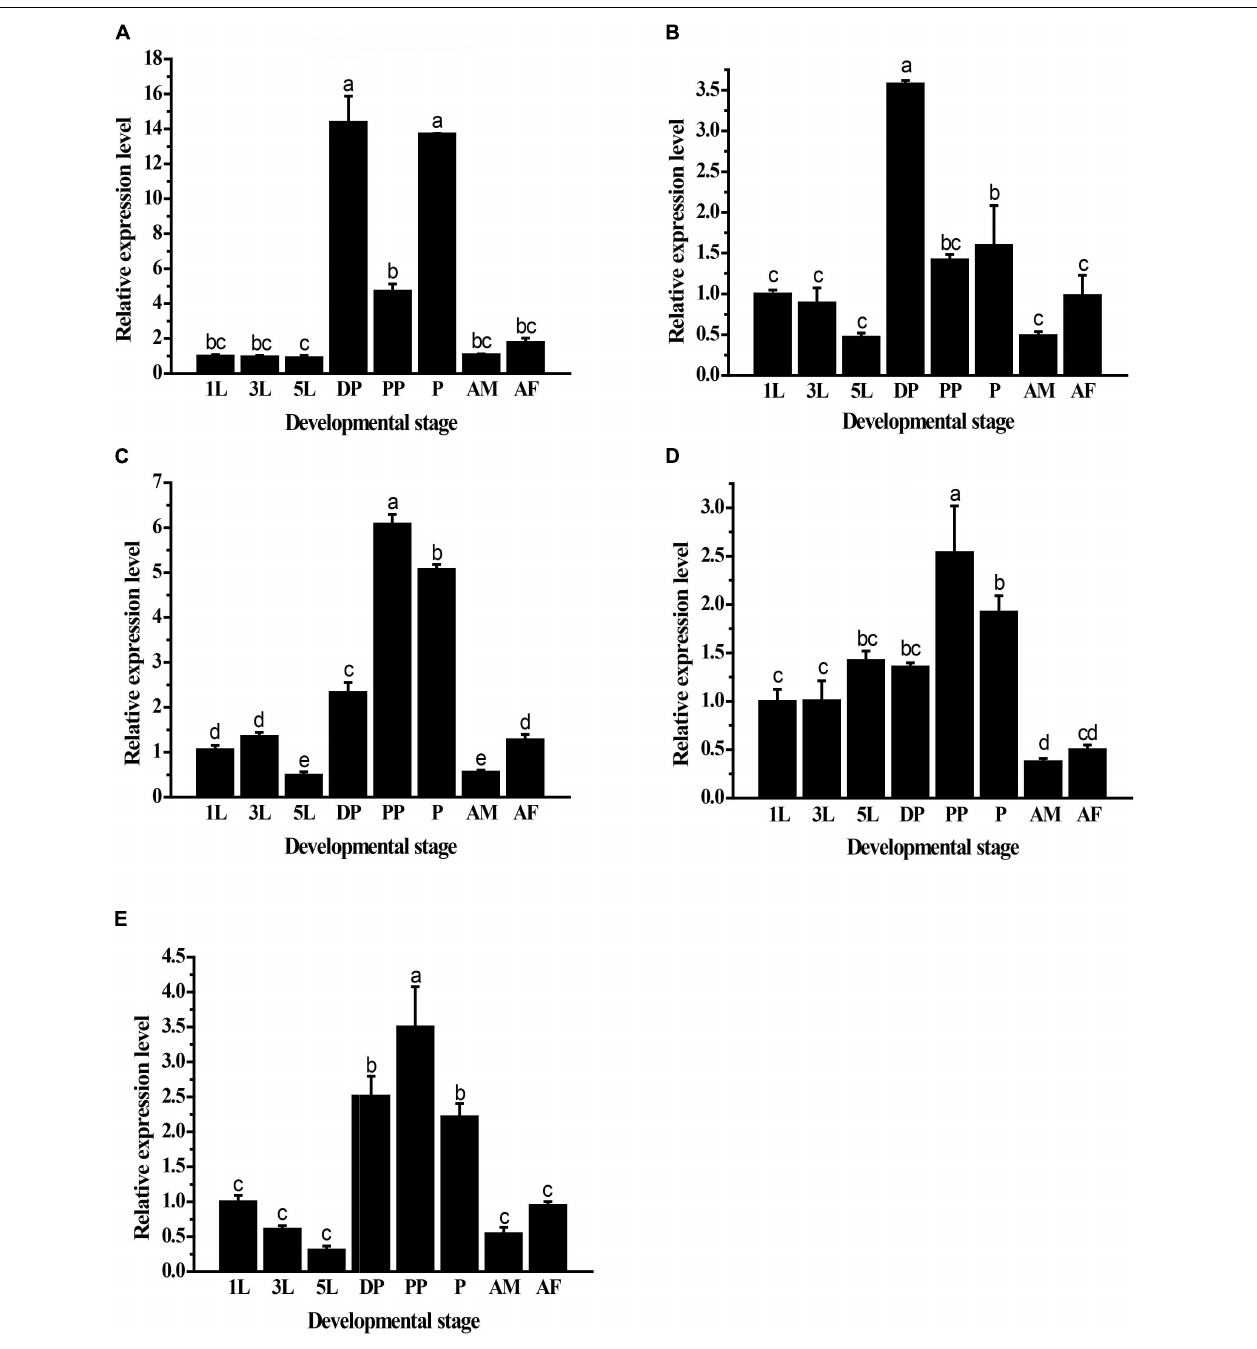
FIGURE 5 | Relative mRNA expression levels of five GpHsps in different developmental stages. (A) GpHsp71.3; (B) GpHsp74.9; (C) GpHsp82.4; (D) GpHsp89; (E) GpHsp93.4 . 1st instar larvae (1L), 3rd instar larvae (3L), 5th instar larvae (5L), diapause larvae (DP), prepupae (PP), pupa (P), male adults (AM), and female adults (AF) of G. pyloalis . The relative expression levels of the GpHsps were determined by comparison with the first instar larvae. Data are shown as the mean ± SE of three biological replicates. Differences among triple repeats were analyzed using one-way analysis of variance (Systat, Inc., Evanston, IL) with Tukey’s post hoc test. The different letters above the bars indicate significant differences ( p <